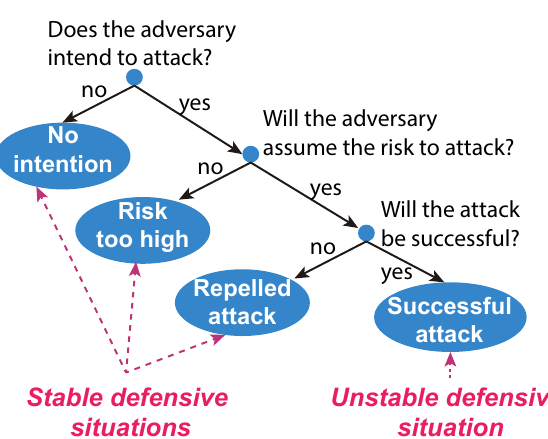
Figure 3. Decision tree on adversary intentions in a bipolar situation for assessment, shown in Christensen’s report [23]. If the relationship between one’s own forces and the adversary is friendly, the adversary will not consider military aggression. On the other hand, if the relationship is hos- tile, the adversary may wish to attack, and one’s own forces may need a military defense against the